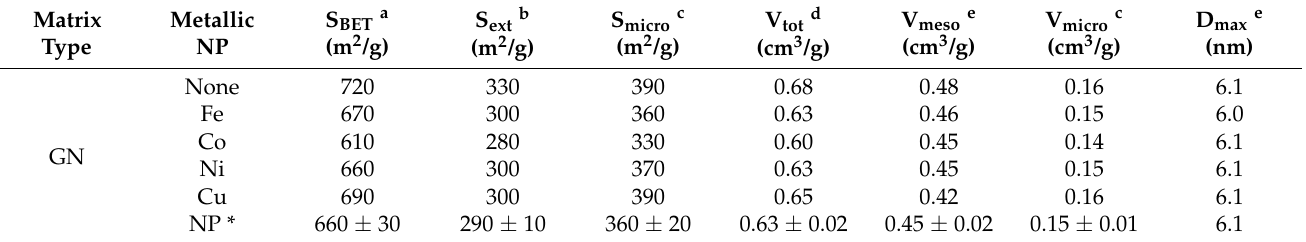
Table 1. Textural parameters of matrixes GN and G2N with and without decoration by metallic nanoparticles before their impregnation by LiBH 4